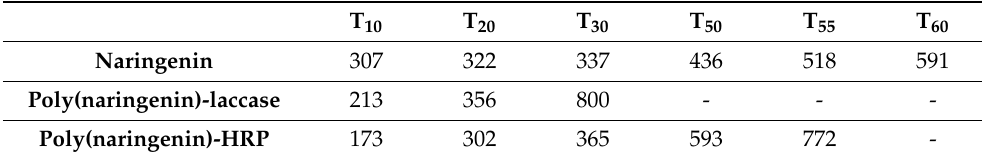
Figure 6. TG curves of naringenin and its polymeric forms obtained by an enzymatic reaction. Table 3. Values of T 10 , T 20 , T 30 , T 50 , T 55 and T 60 of naringenin, poly(naringenin)-laccase and